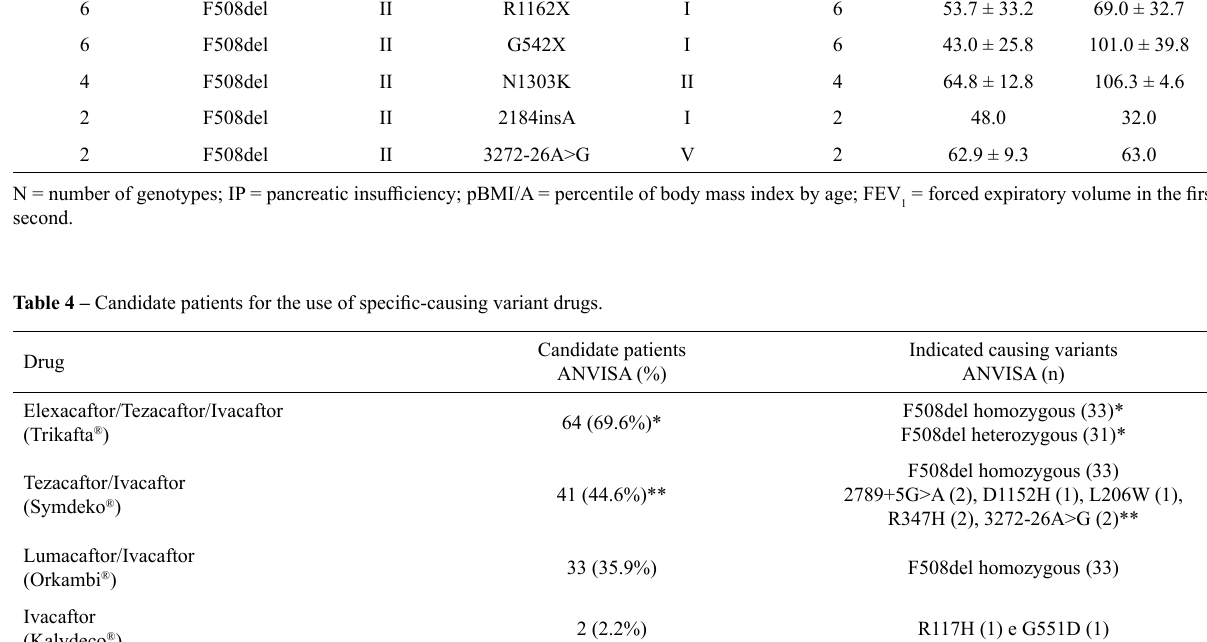
Table 3 – Clinical, nutritional, and pulmonary function characteristics according to genotyping (including only patients with at least one F508del allele). N